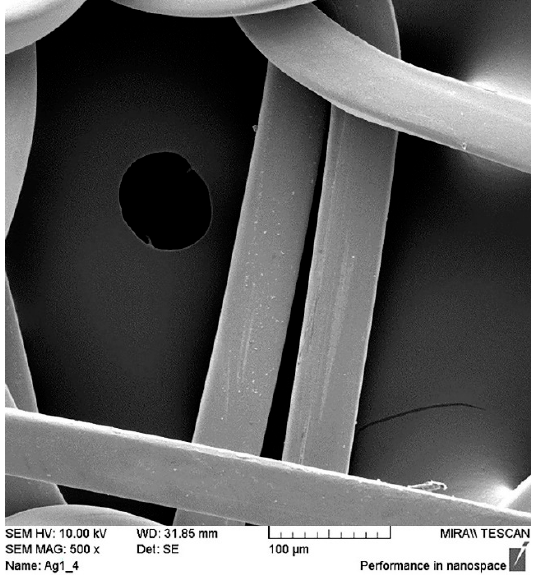
Figure 4. SEM micrograph of the conductive untreated PA/Ag sample under a magnification of 500×.